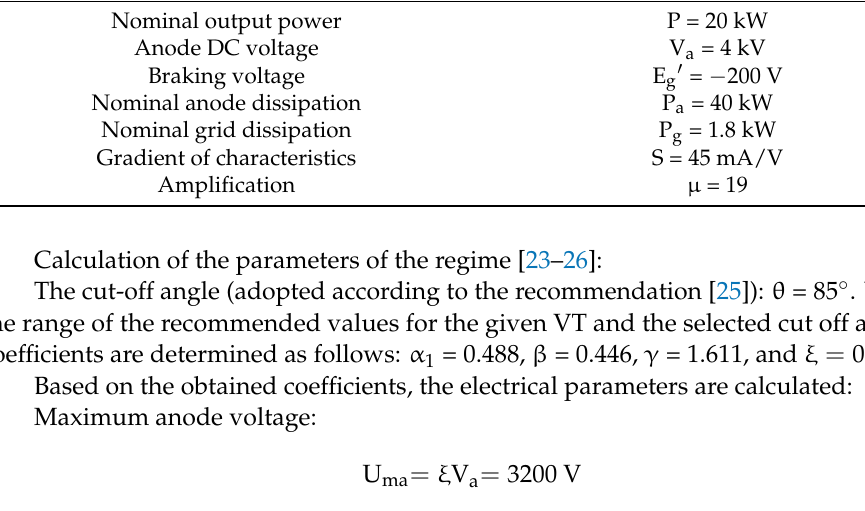
Table 1. Input parameters for generator calculation [20].